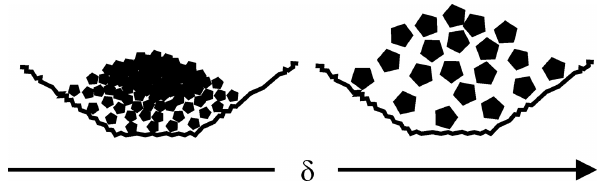
Figure 11. These illustrations portray particle agitation per unit of flow mass that increases as grain size δ increases (all the other fea- tures being the same). In this figure, the more agitated particles are represented by more distant polygons. The closer the position to the rough channel surfaces, the larger the agitation of the particles. These sketches are based on high-speed video camera studies of granular flows (Cagnoli and Romano, 2012a,